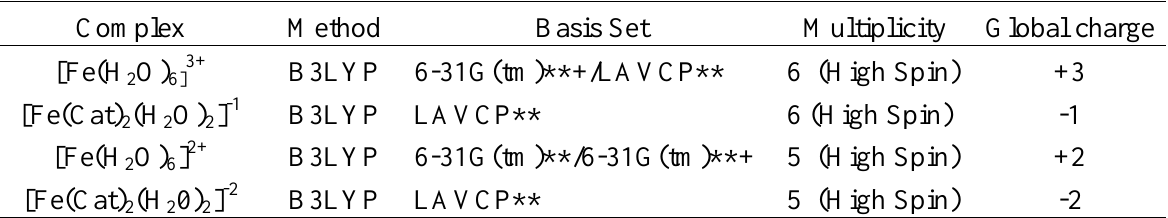
Table 1. Functionals and Basis sets used in DFT calculations.